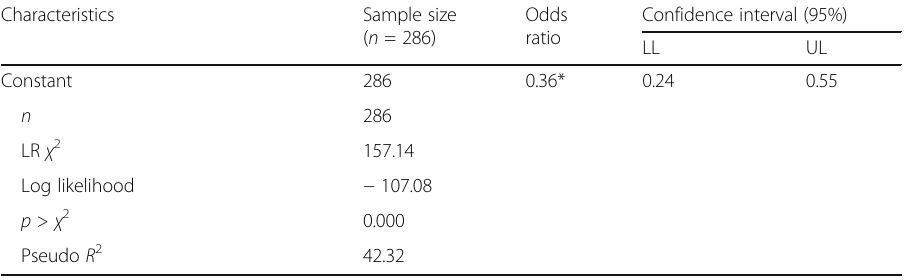
Table 6 Logistic regression results of induced abortion by socioeconomic and demographic characteristics of women